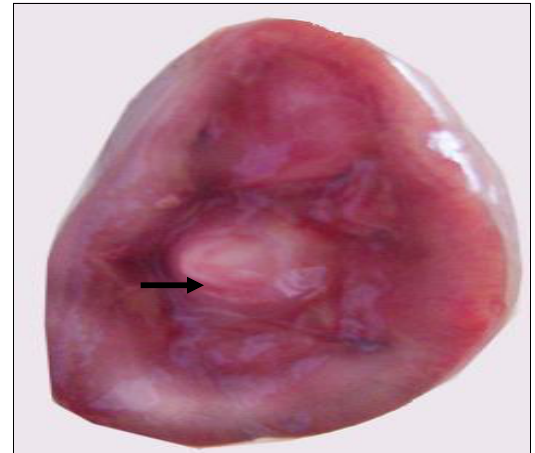
Fig:5 Gross rabbit kidney of 3 rd (positive control) group at 24- 48 hr. post challenge show focal raised necrotic foci.